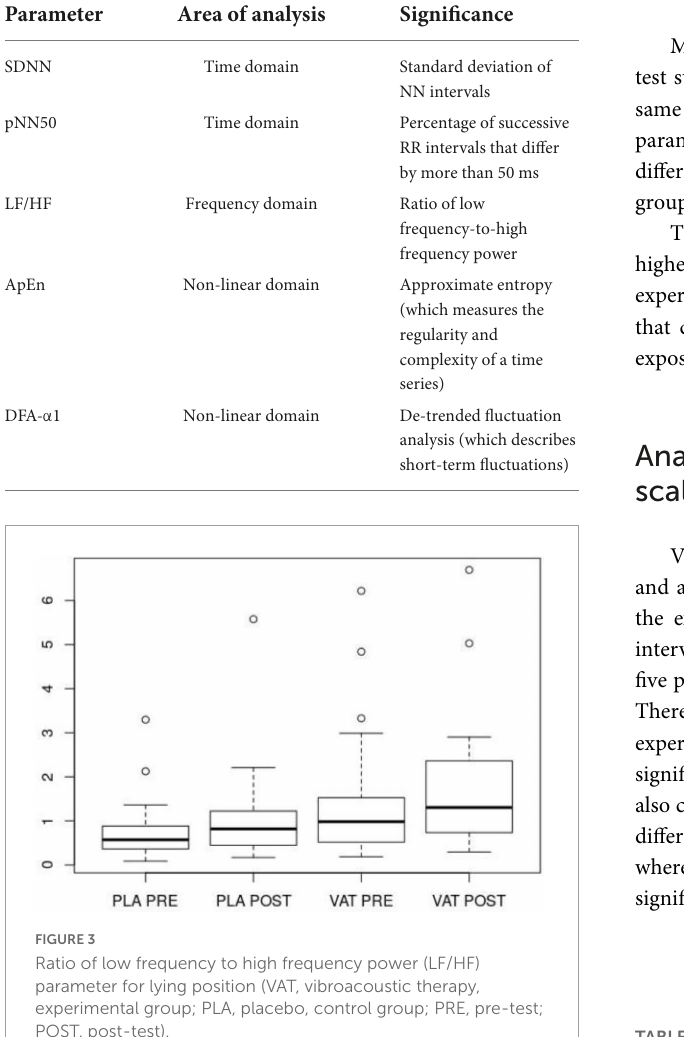
and control (placebo) group (VAS-S, visual analogue scale for stress;